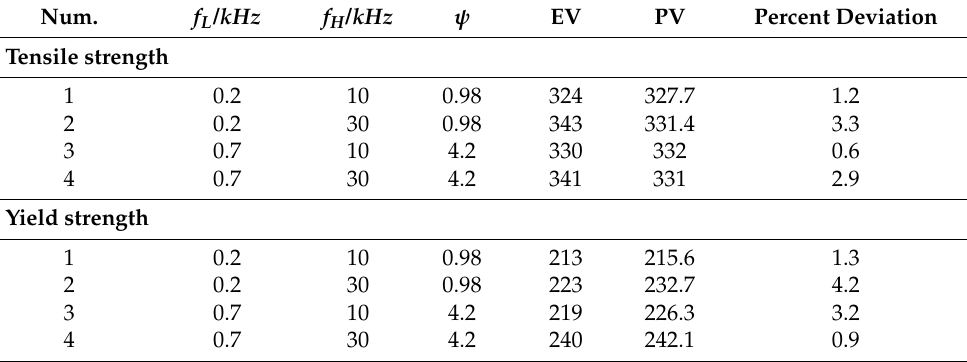
Table 5. Validation of regression models by HPVP-GTAW for AA 5456 aluminum alloy.